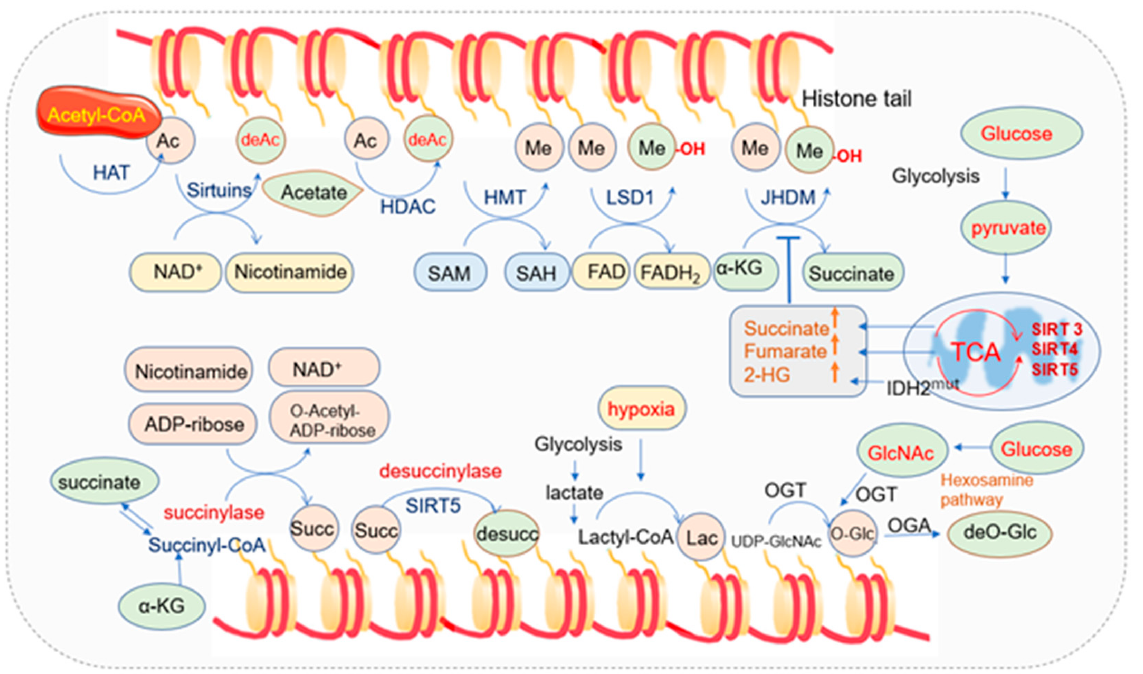
Figure 2. Mitochondria metabolites and histone post-translation